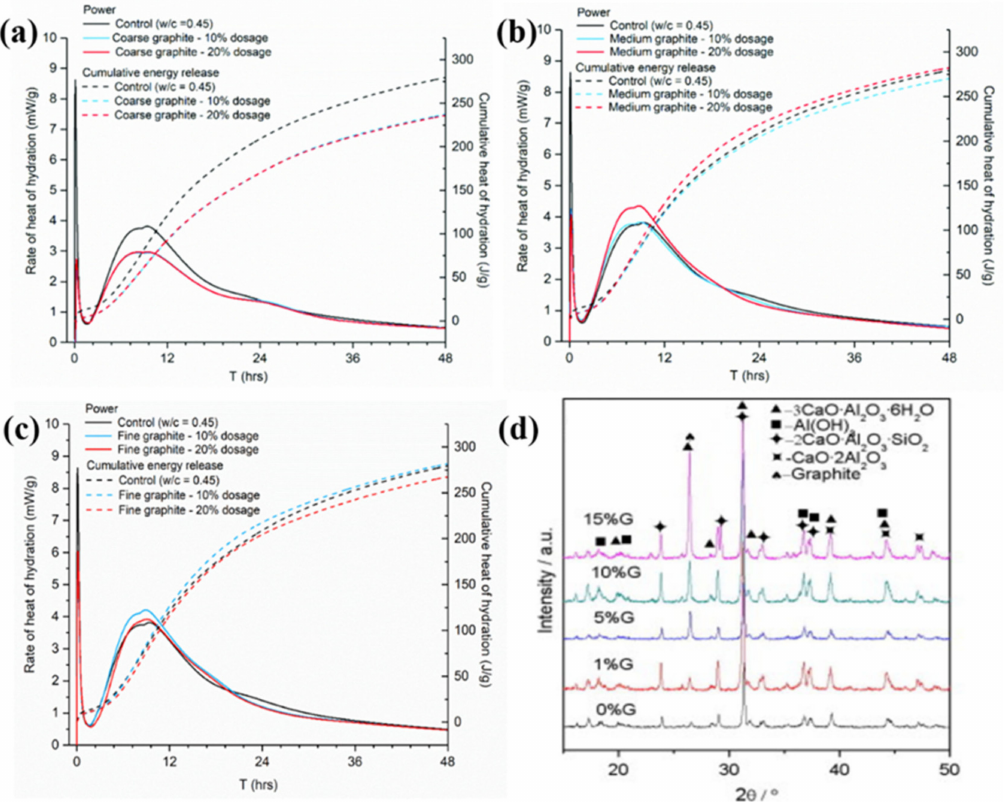
Figure 7. Effect of graphite size and concentration on cement paste hydration: ( a ) coarse, ( b ) medium, and ( c ) fine graphite (reprinted (adapted) from [3] which is an open access article and permits unrestricted use); ( d ) XRD patterns of graphite-aluminate cement composite paste (reprinted (adapted) with permission from [71] ©2012 with permission from